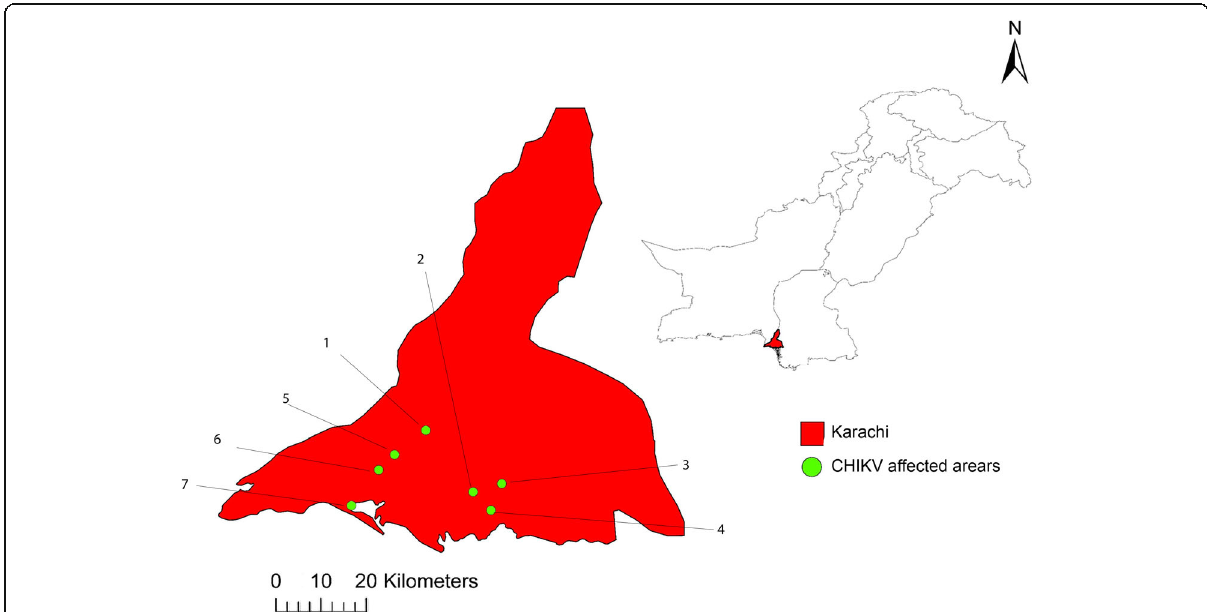
Fig. 3 Cases of reported chikungunya from different towns of Karachi (2016-2017). 1, New Karachi; 2, Shah Faisal; 3, Malir; 4, Landhi; 5, Orangi; 6, Rais Goth; 7, Bin Qasim (Ali and Dasti 2018). Map was created by ArcMap10.3 software (http://desktop.arcgis.com/en/arcmap/10.3/main/get-